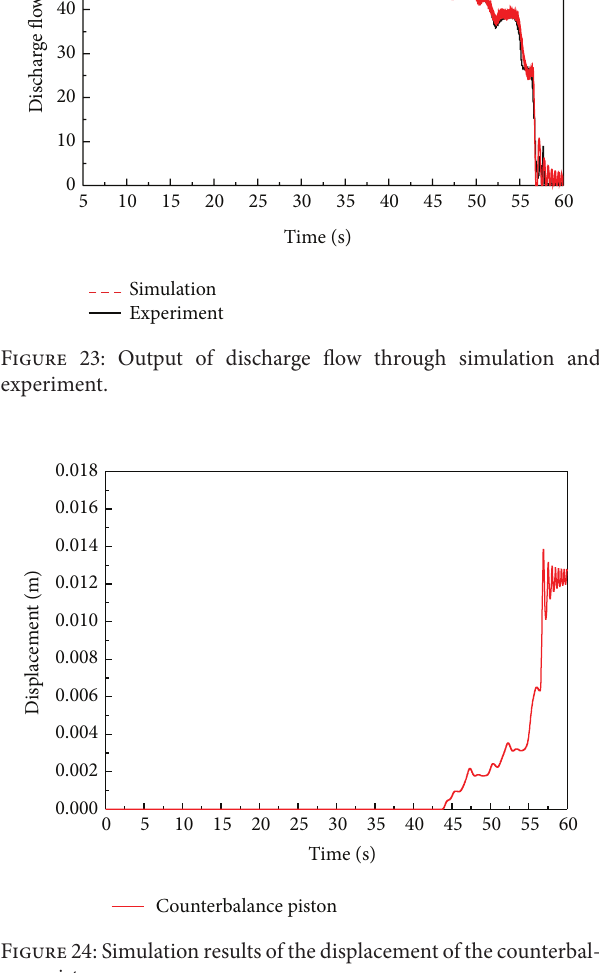
Figure 24: Simulation results of the displacement of the counterbal- ance